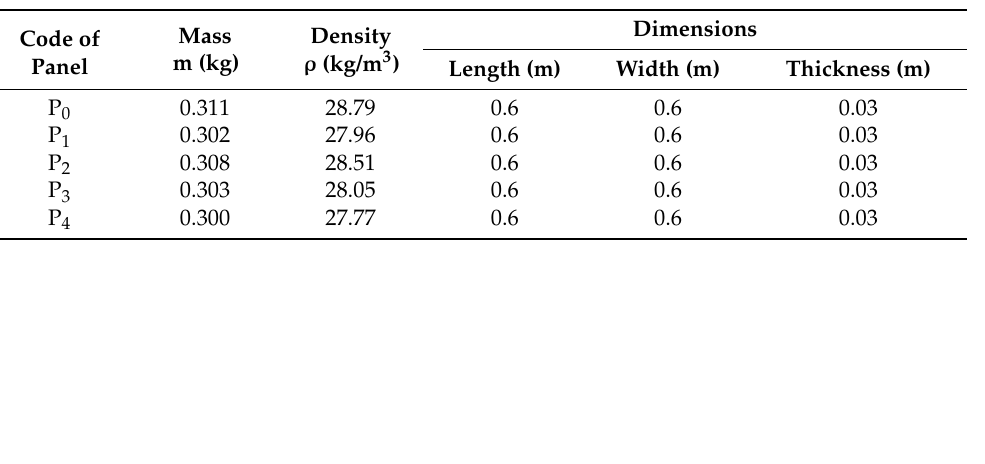
Table 1. The physical features of